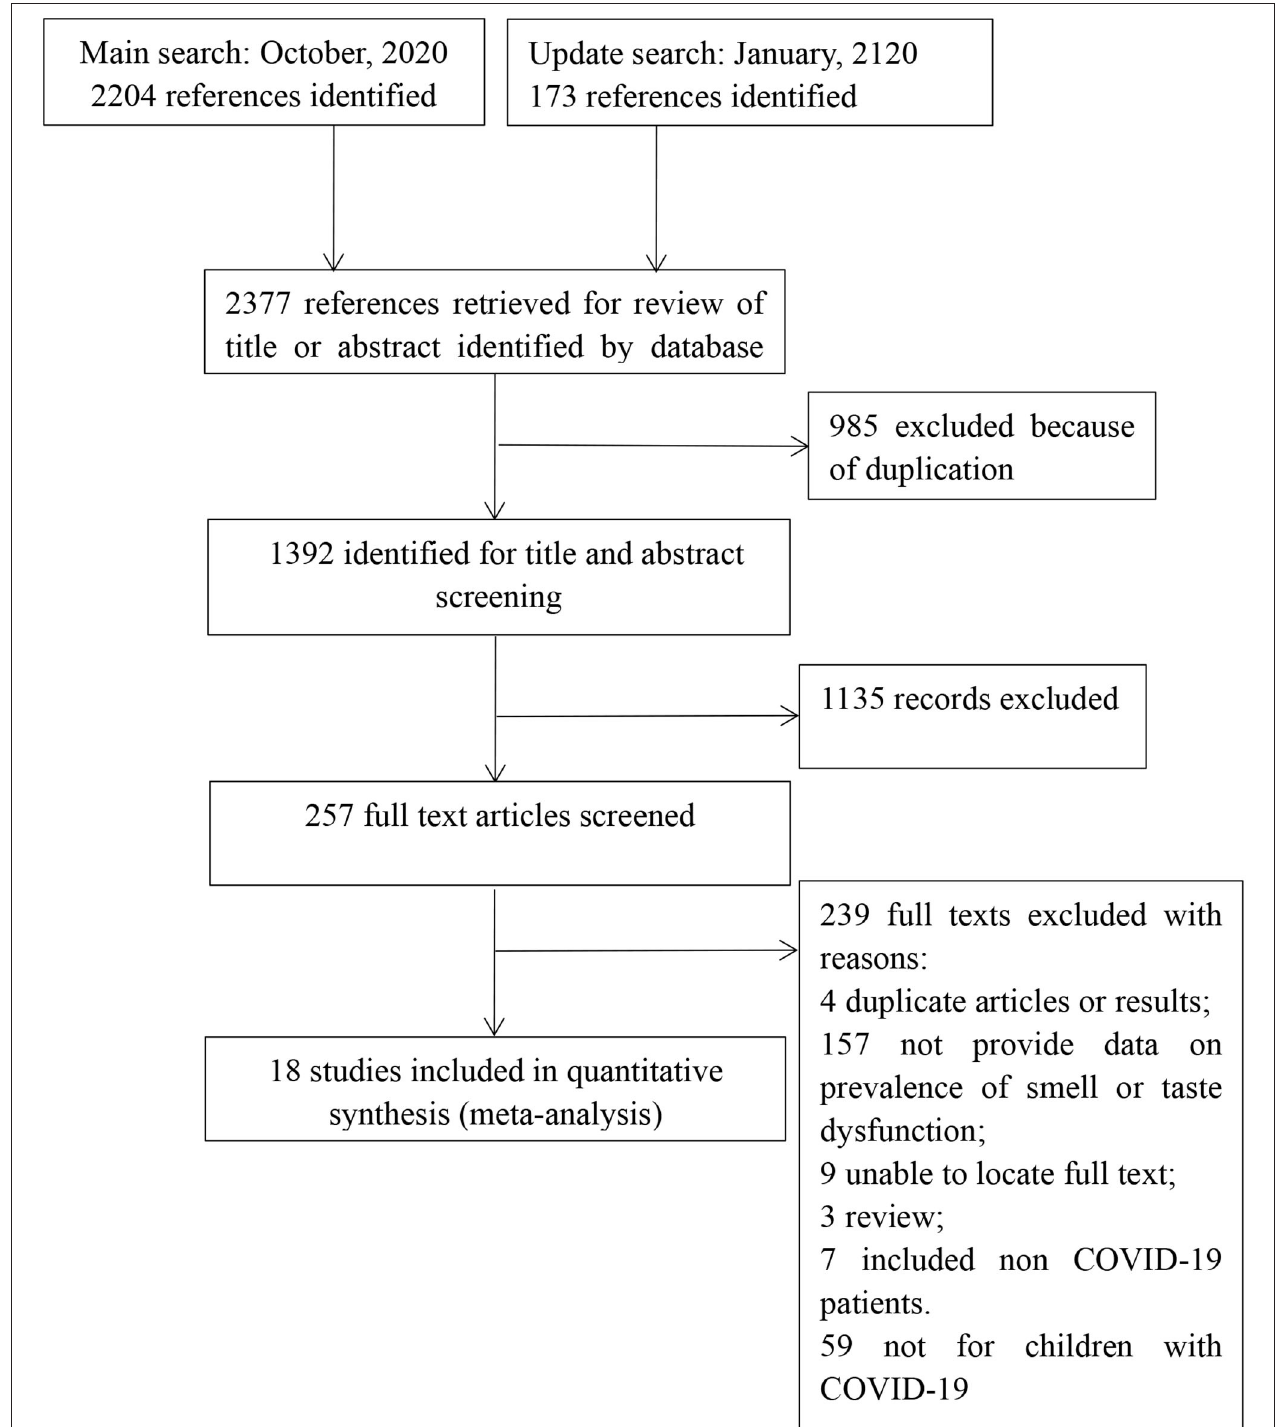
FIGURE 1 | Flow of studies through review.